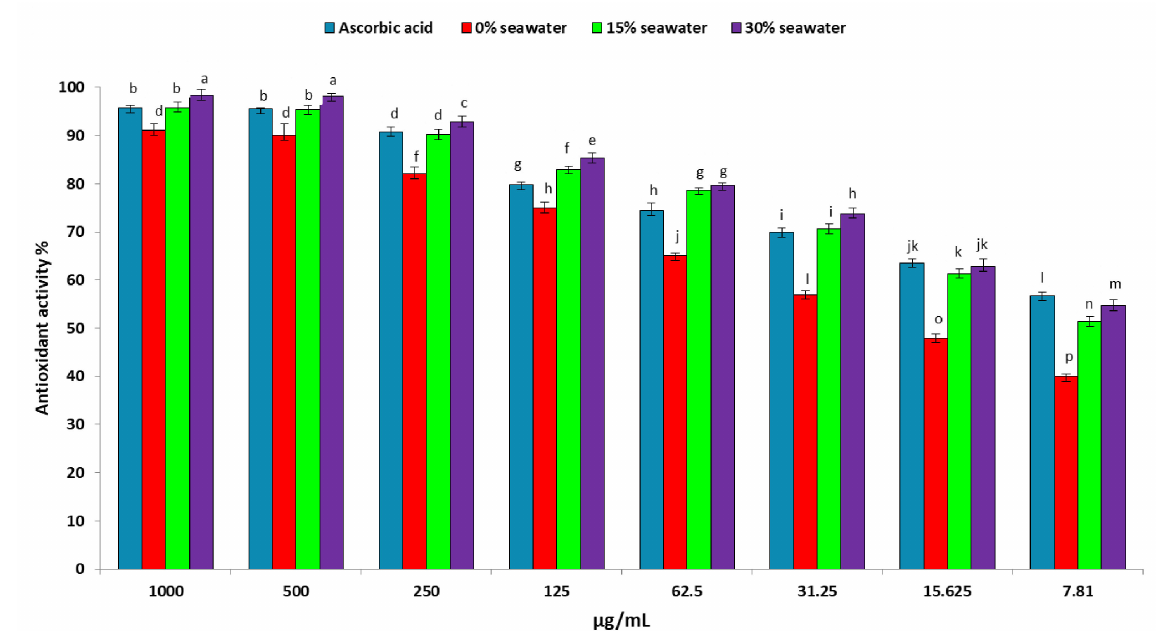
Figure 2. Antioxidant activity of the crude extract of A. ochraceus cultured on different levels of salinity. Different letters indicate significant differences between the treatments according to an LSD test at p < 0.05.